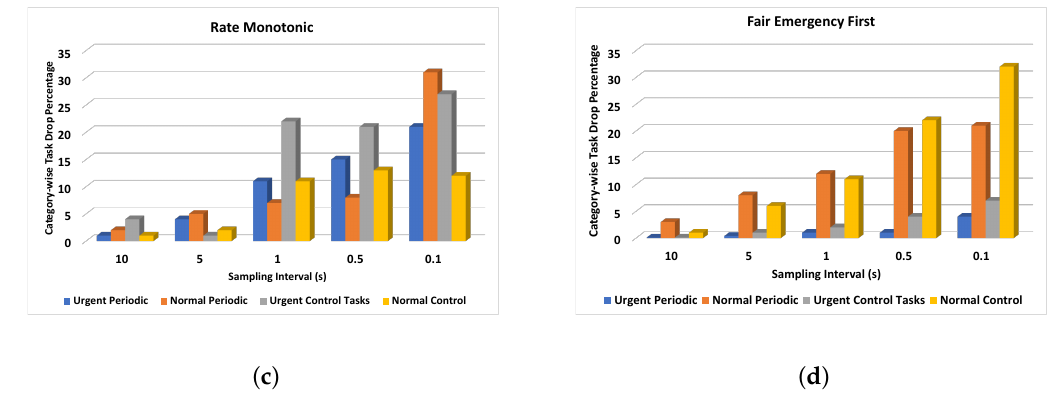
Figure 11. Task dropping rate impact on varying sampling rates using ( a ) control output scheduling, ( b ) earliest deadline first, ( c ) rate monotonic, and ( d ) fair emergency first.